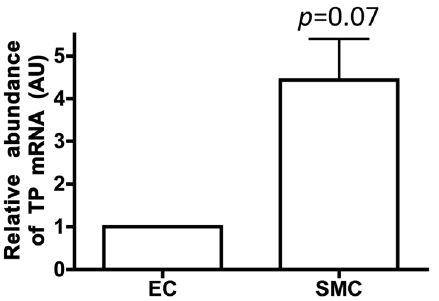
Figure 2. TP expression was higher in smooth muscle cells than in endothelial cells. Relative abundance of TP mRNA in DA endothelial cell (EC) and smooth muscle cell (SMC) on gestational day 21. Values are expressed as the mean 6 SEM.